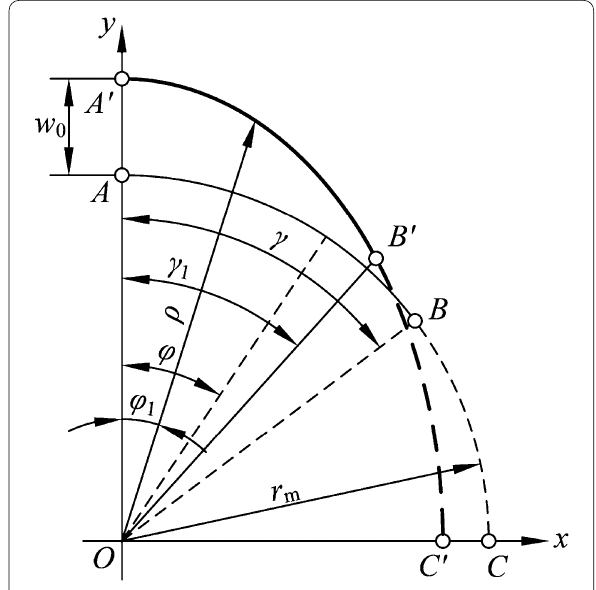
Figure 2 Schematic diagram of the piecewise deformation of a ring under a